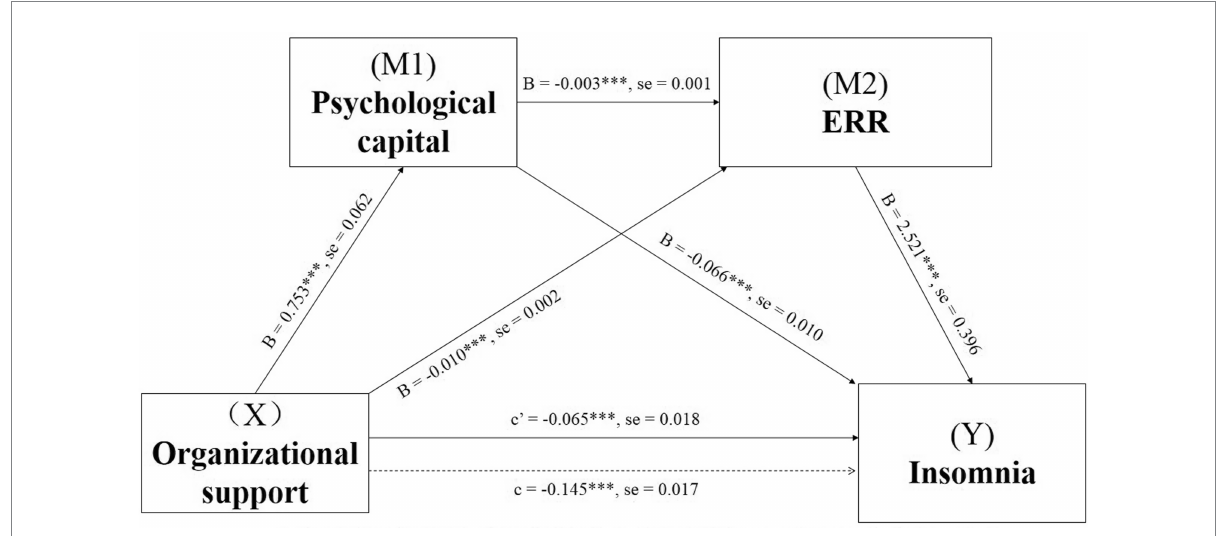
FIGURE 1 Serial-multiple Mediating effects of psychological capital and ERR between perceived organizational support and insomnia with non-standardized beta values and standard error. *** p < 0.001. ERR means Effort-Reward ratio.